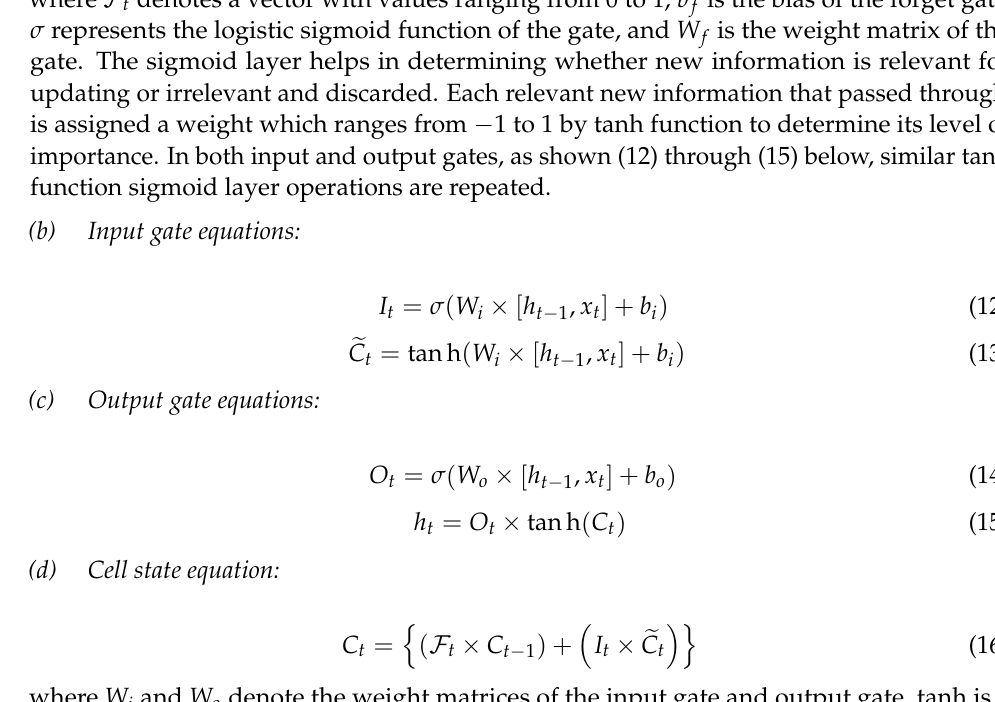
Figure 4. Structure of chained deep learning LSTM blocks and their symbols/notations. The equation below illustrates the calculation processes involved in DL-LSTM NNs.